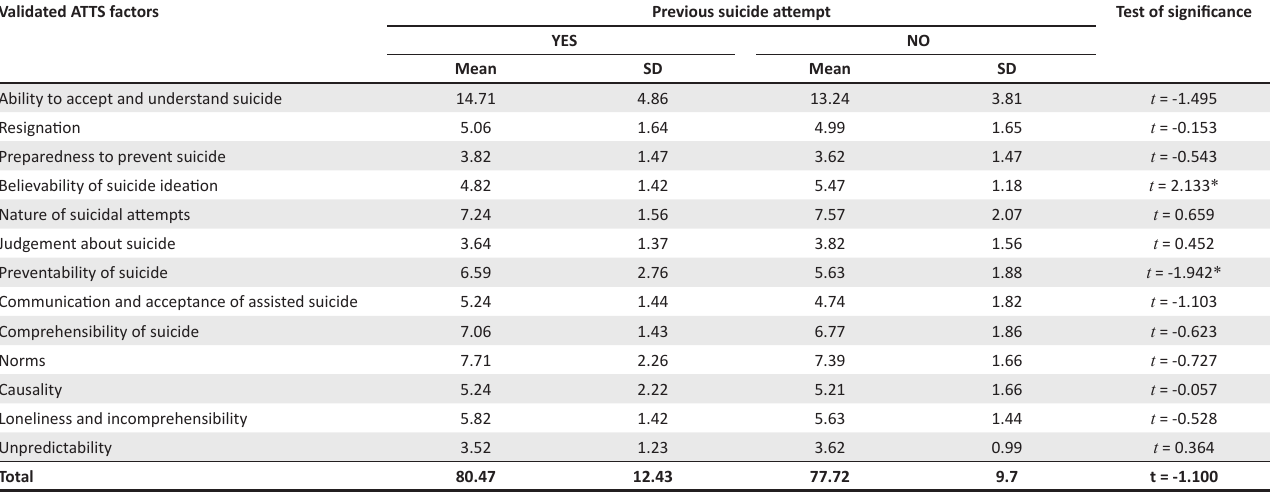
TABLE 4: Comparison of the validated Attitudes Toward Suicide Scale scores among participants based on participants who reported having at least one suicide attempt during their life time. Validated ATTS factors Previous suicide attempt